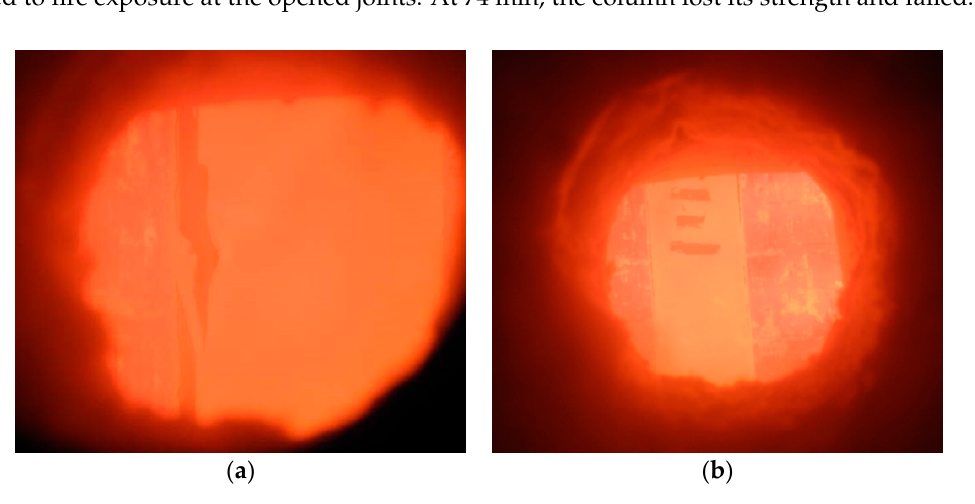
Figure 4. View of test specimens through the observation window: ( a ) HSS-C1; ( b ) HSS-C3.